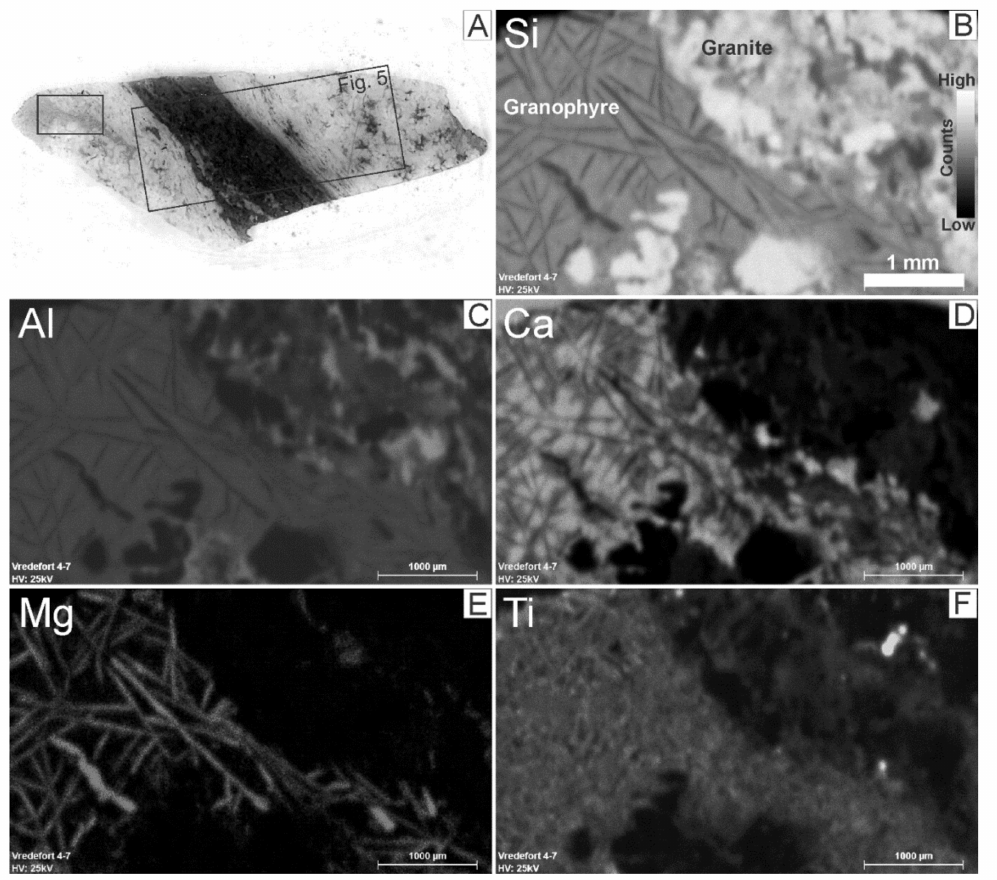
Figure 4. ED- µ XRF maps of a selected area in the thin section. ( A ) Thin section photograph. The small rectangle shows the mapped area in ( B – F ), where the clast is in contact with the host granophyre. The larger rectangle shows the mapped area in Figure 5, featuring the PT vein and adjacent granite. The horizontal length of the field of view is 35 mm. ( B ) Si intensity map, showing that the clast is more siliceous than granophyre. ( C ) Al intensity map, showing that Al distribution in the clast is inhomogeneous but roughly comparable with granophyre. ( D ) Ca intensity map, showing that granophyre is enriched in Ca compared to granite. ( E ) Mg intensity map, showing that the granophyre is enriched in Mg, especially within the orthopyroxene needles, compared to granite clast. ( F ) Ti intensity map, showing that granophyre’s matrix is enriched in Ti compared to granite, in which Ti is only locally elevated. The scale bar in ( B – F ) is 1